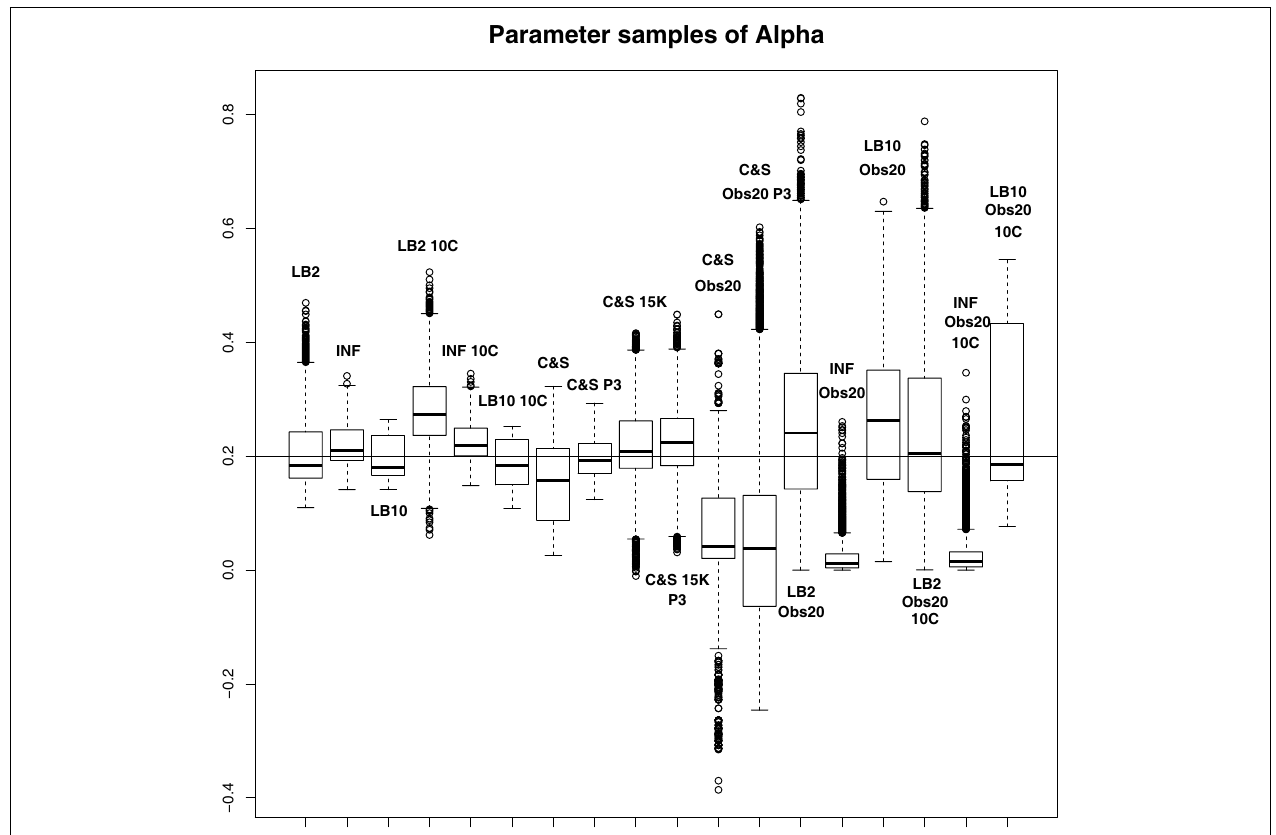
FIGURE 8 | Average posterior distributions of parameter (cid:11) from equation (62) over 3 datasets . From left to right: LB2, INF, LB10, LB2 10C, INF 10C, LB10 10C, C&S, C&S P3, C&S 15K, C&S 15K P3, C&S Obs20, C&S Obs20 P3, LB2 Obs20, INF Obs20, LB10 Obs20, LB2 Obs20 10C, INF Obs20 10C, and LB10 Obs20 10C. The solid line is the true parameter. For definitions, see Tables 3 and 4 . For an explanation of the boxplot form, see the beginning of Section 6. Figure reconstructed from Macdonald and Husmeier (2015).